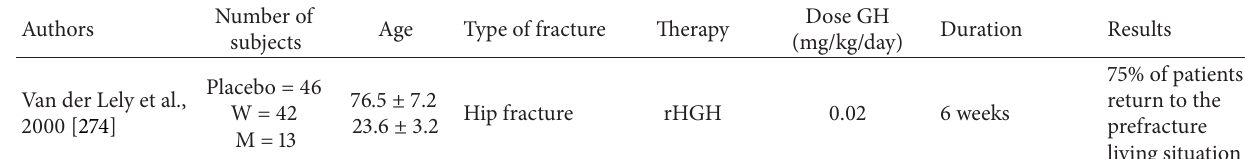
Table 3: Effect of GH and IGF-1 administration on bone fractures